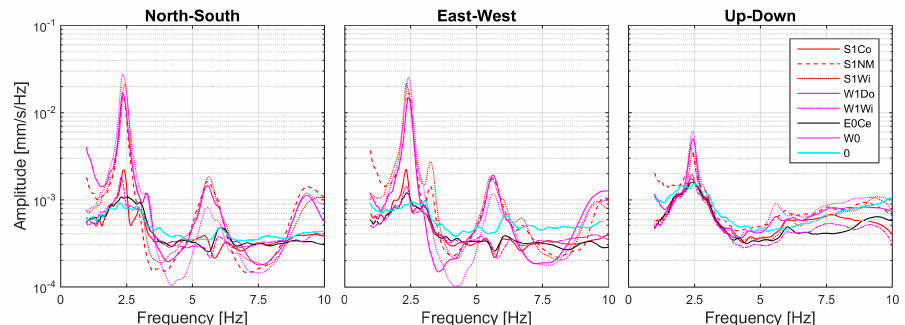
Figure 6. Fourier amplitude spectra of velocity, Krishna